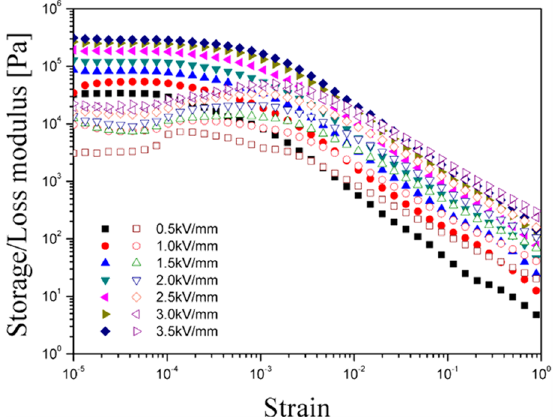
Figure 3. Amplitude sweep of the PMMA-PNMA particle-based electrorheological (ER) fluid (closed symbols for G' , open symbols for G''